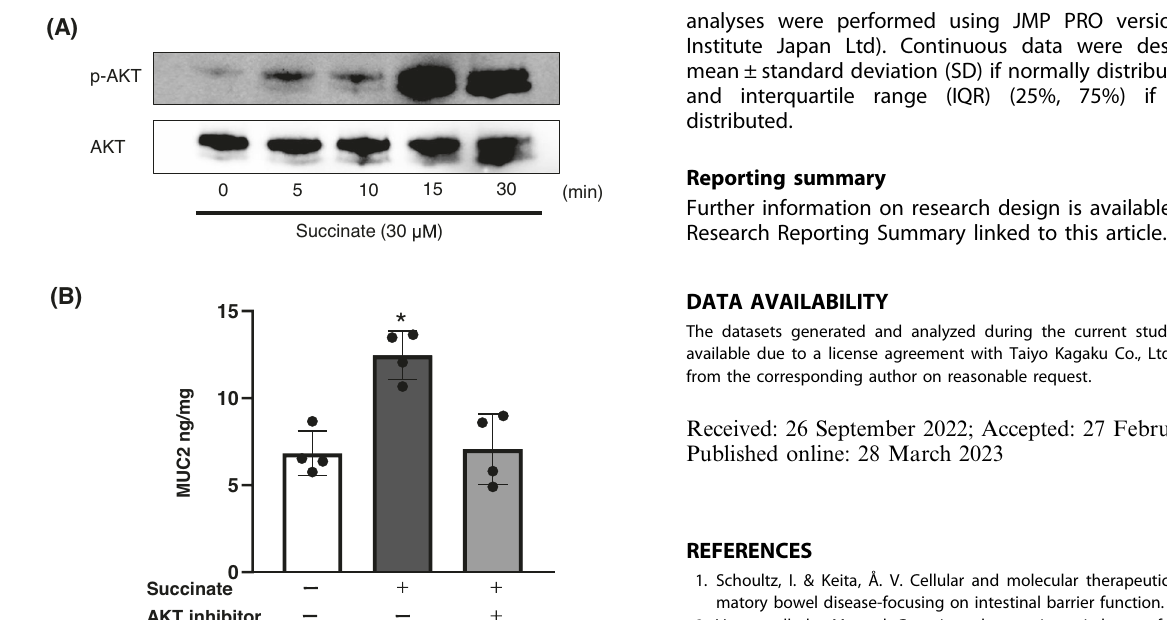
Fig. 5 Mucin 2 (MUC2) production in colon mucus cells, LS174T cells. A MUC2 mRNA expression in control cells and LS174T cells treated with four short-chain fatty acids (acetate, butyrate, propionate, succinate) (* p <0.01, vs. all). B ELISA for MUC2 in control and succinate-treated cells (** p <0.05, vs. control). C Fluorescence imaging of control, LS174T cells, and succinate-treated cells stained with rhodamine-phalloidin and Hoechst.